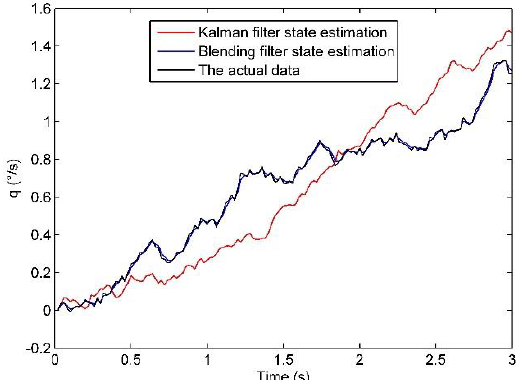
Figure 3. Example of a bandpass filter: ( a ) bandpass filter circuit diagram; ( b ) frequency response diagram.